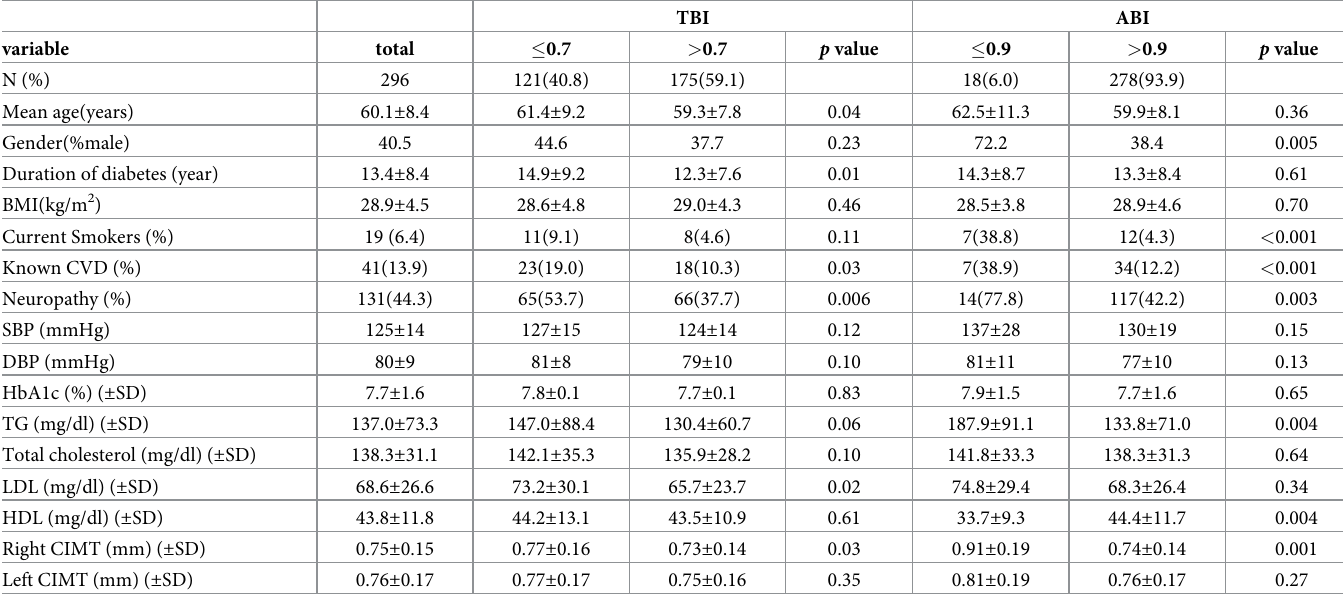
Table 1. Characteristics of the study participants.